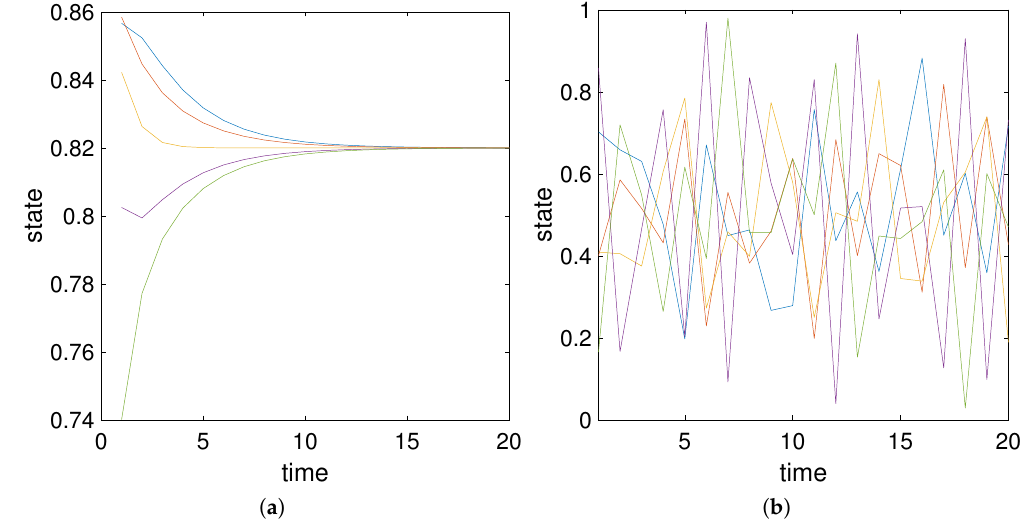
Figure 1. Illustration of the time evolution of the states of the nodes in a linear chain of five nodes using a classical ( a ) and quantum ( b ) transport dynamics with random initial condition at the